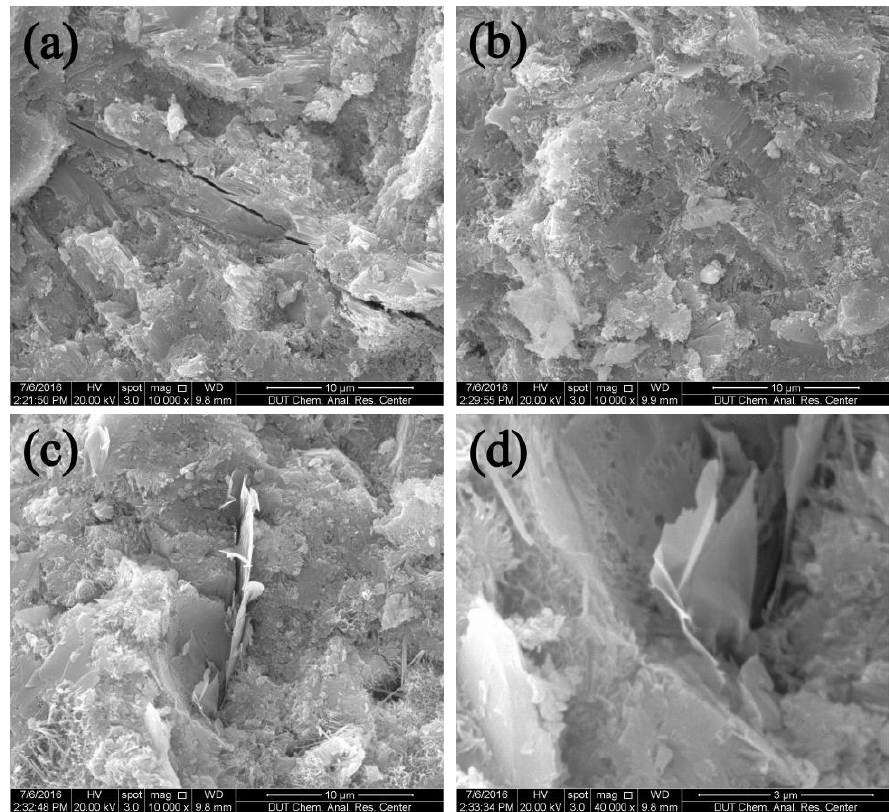
Figure 11. Scanning electron microscope (SEM) images of ( a ) the plain cement paste and ( b ) the GNP–cement composite at the age of 28 days. ( c ) The GNPs inserted into the hydration productions of cement. ( d ) The plicate morphology of GNPs in cement.